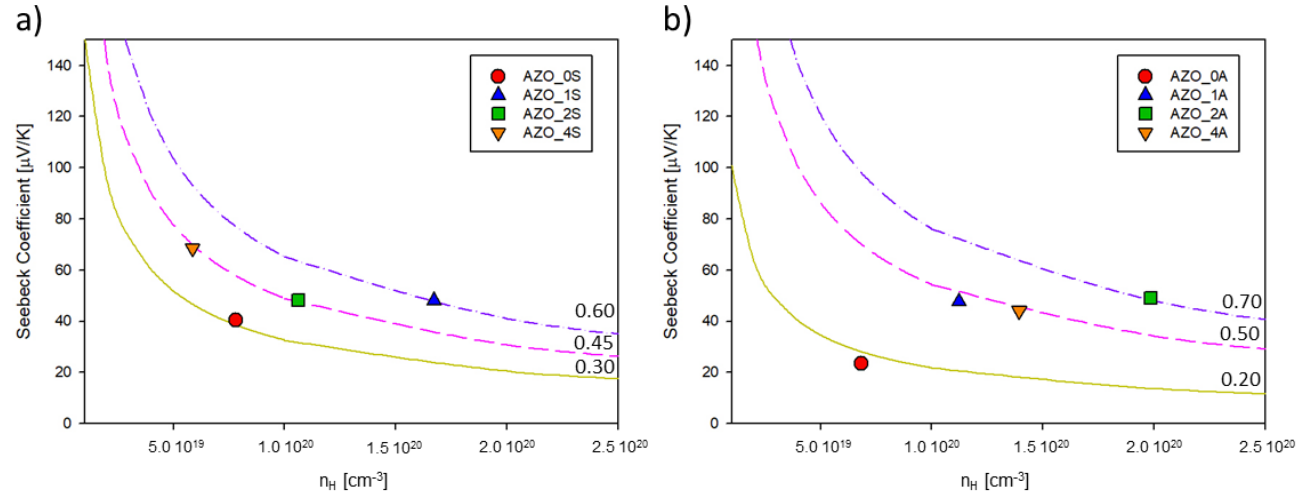
Figure 8. Pisarenko plot at 300 K for thin films deposited on ( a ) silica (series AZO_xS) and ( b ) on Al 2 O 3 (series AZO_xA).